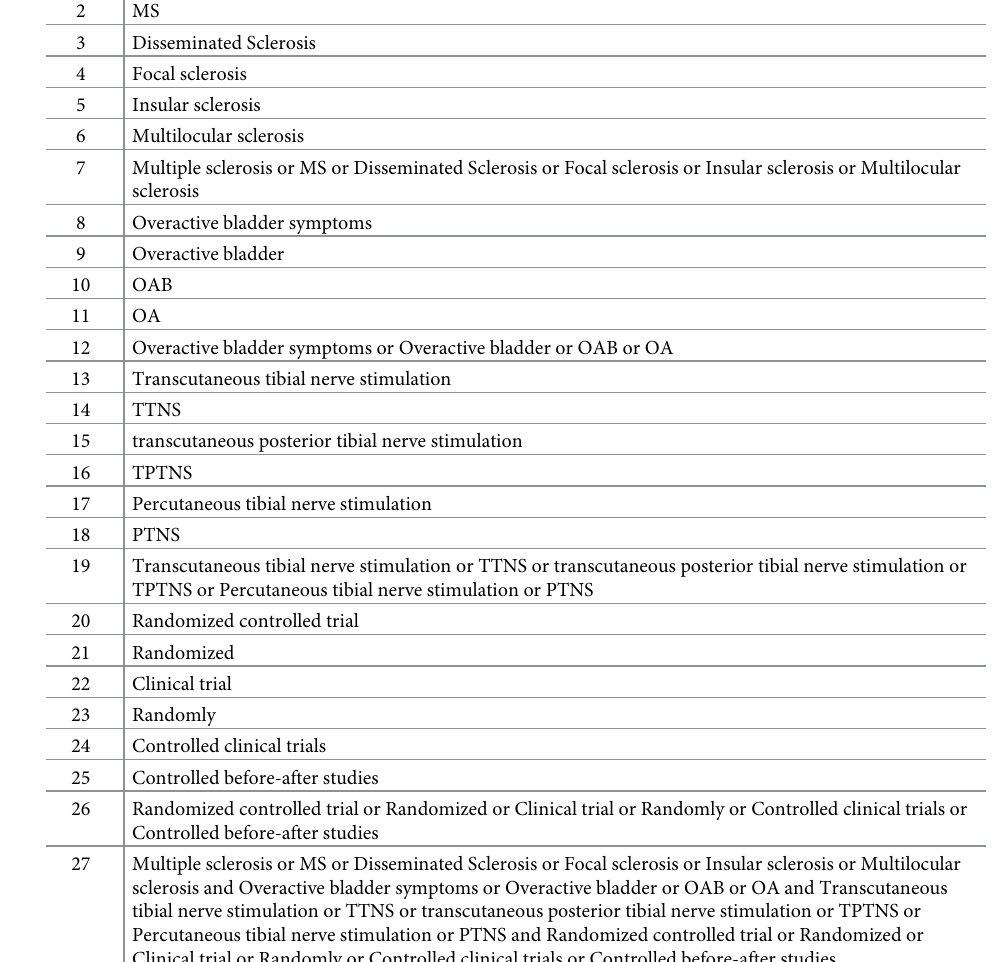
Clinical trial or Randomly or Controlled clinical trials or Controlled before-after